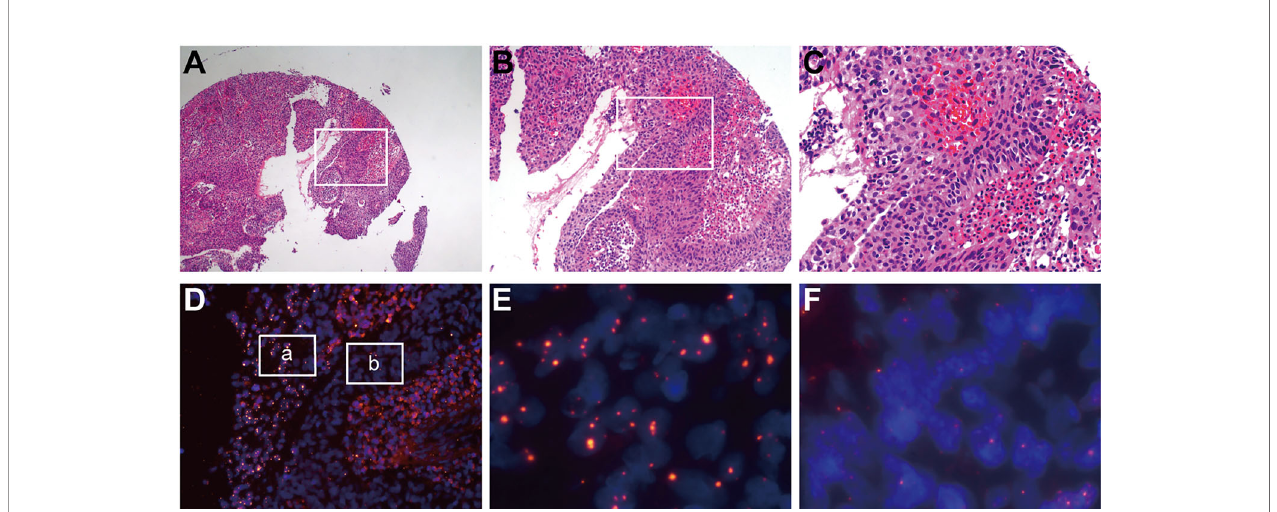
FIGURE 3 | HPV signaling suggests clonality and heterogeneity in cervical cancer tissue. In sample No. 1321, two groups of cancer cells in the same cervical cancer tissue showed no difference in cell and nuclear morphology after HE staining and were pathologically identi fi ed as the same type of cells (A – C) , which were distinguished signi fi cantly by HPV probes (D) . Every cell in the “ a ” group (E) showed HPV integration, the HPV signal area was large, and the intensity was high, suggesting intense HPV integration. In the “ b ” group (F) , some of the cells showed HPV integration, the HPV signal area was small, and the intensity was low, suggesting a low